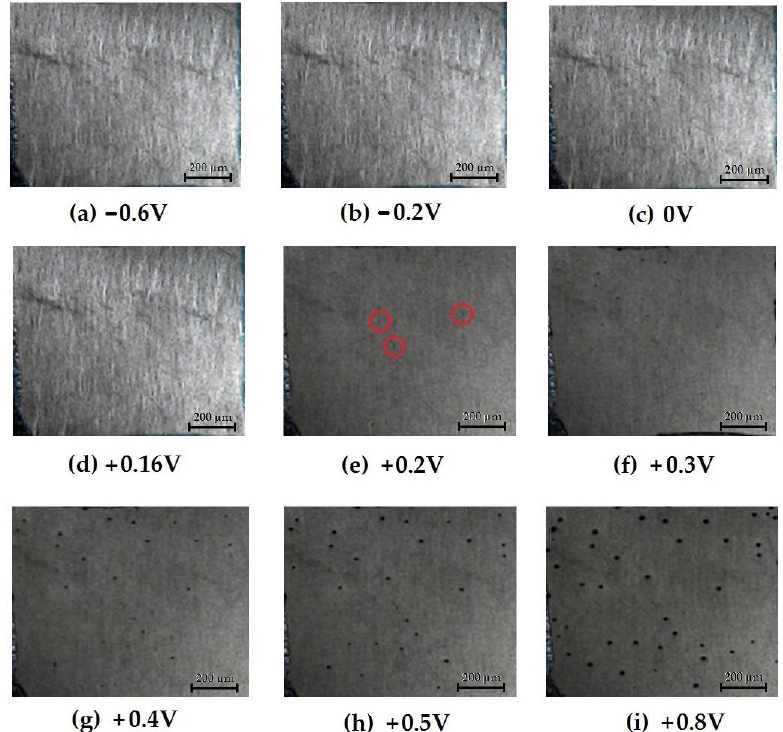
Figure 6. Change in the state of carbon steel surface during anodic polarization of the metal at po- tentials of: ( a ) − 0.6 V; ( b ) − 0.2 V; ( c ) 0 V; ( d ) 0.16 V; ( e ) +0.2 V; ( f ) +0.3 V; ( g ) + 0.4 V; ( h ) + 0.5 V; ( i ) + 0.8 ( i ) +0.8